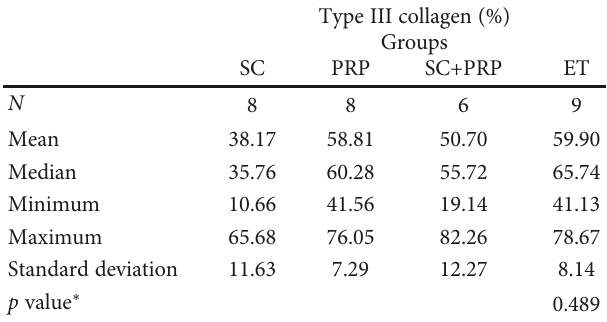
Figure 7: Histograms of the proportions of collagen (types I or III) in each group. Table 11: Analysis of the percentage of type III collagen in each